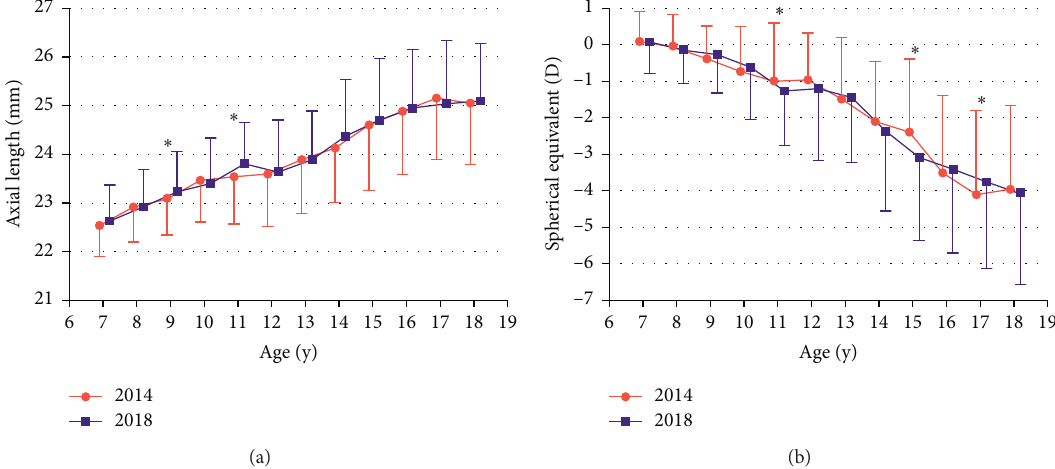
Figure 1: Trends of axial length (a) and spherical equivalent (b) in children from 7- to 18-year-olds in 2014 and 2018.